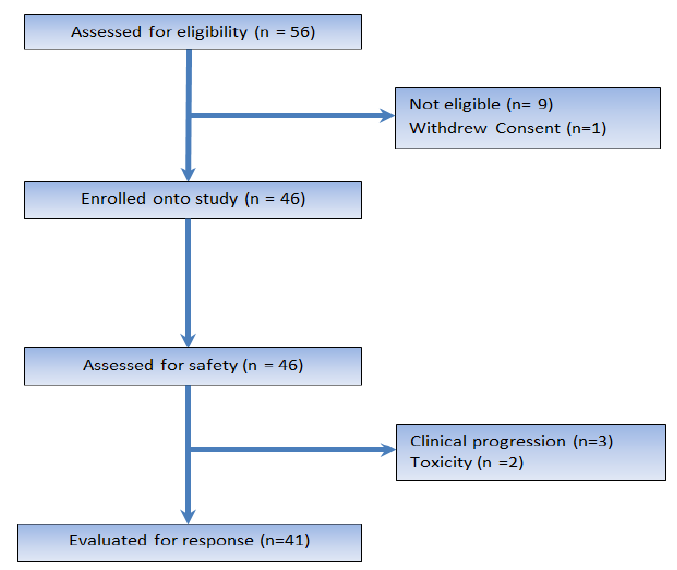
Figure 1. This is a CONSORT diagram showing the eligible, excluded and response-evaluable patients.